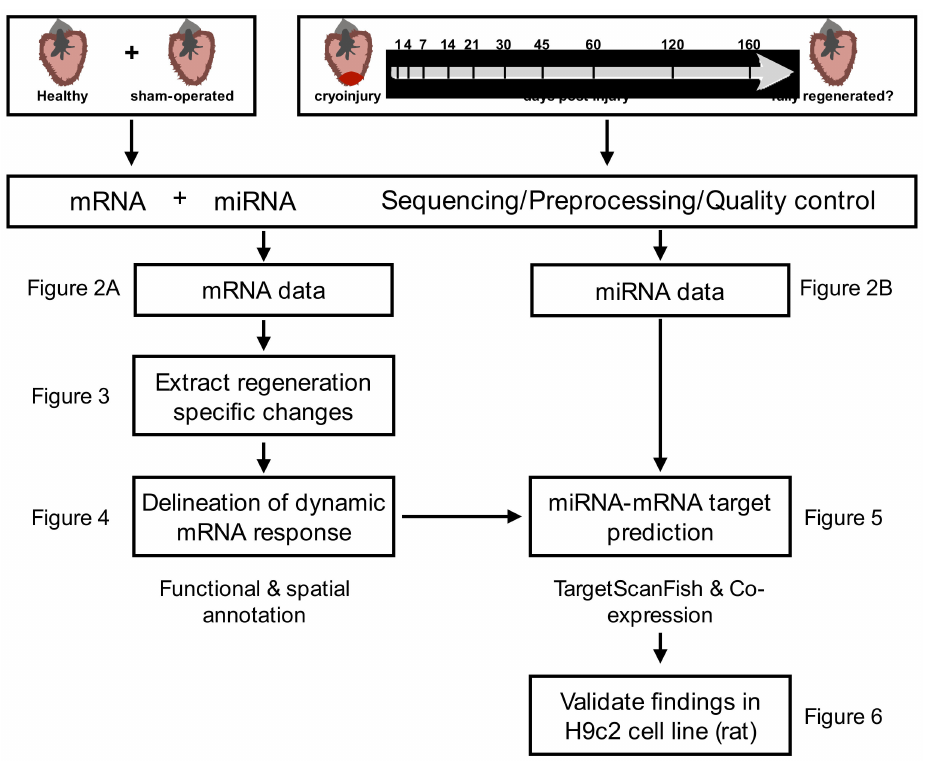
Figure 1. Schematic workflow of the study design and the analysis